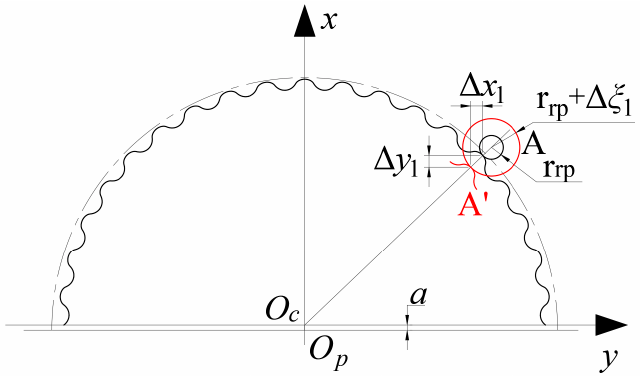
Figure 5. Schematic diagram of the grinding radius error of the grinding wheel. Table 1. Variation coefficient of the machining error on the tooth